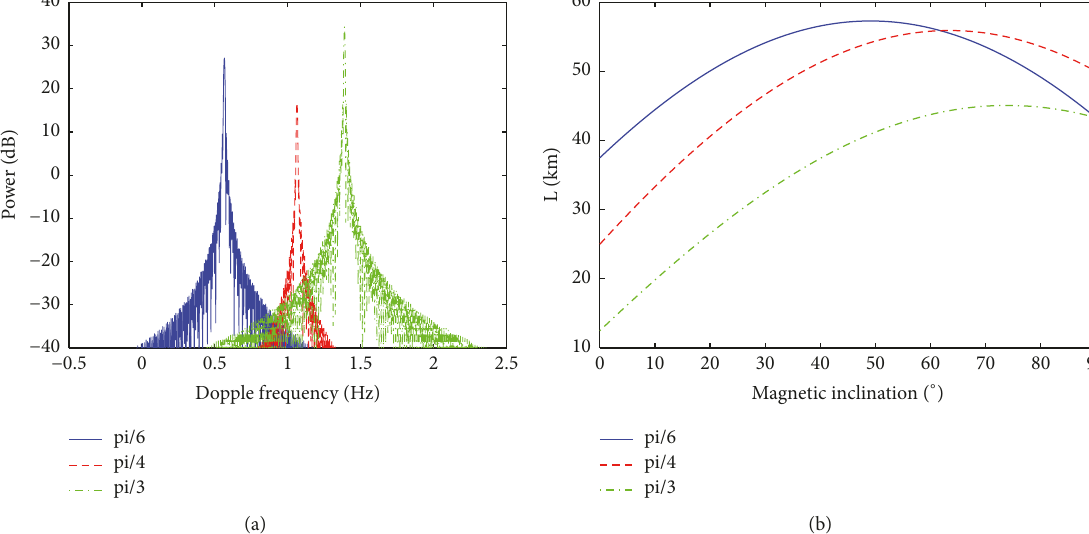
0.1657Hz, which means the vertical drift velocities of the most fluctuation irregularities is about 4.14m/s. The main peak of irregularities in range distribution is 369km. Noted that the Doppler distribution is stratified and the oscillating shapes, which are consistent with Figure